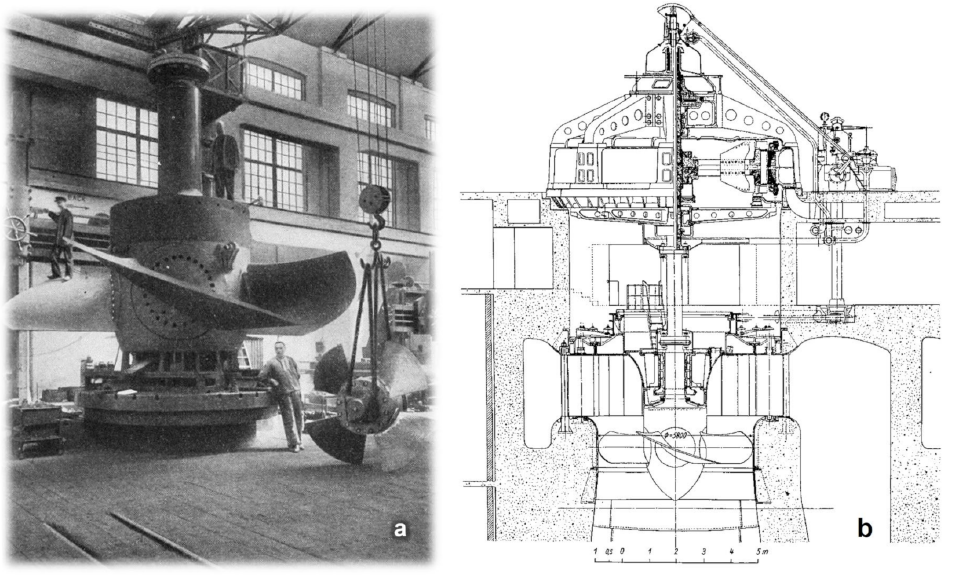
Figure 13. Kaplan turbine for the Lilla Edet hydropower plant, Sweden, 1925. ( a ) Photo of turbine impeller [5]; ( b ) Cross section of turbine and generator.